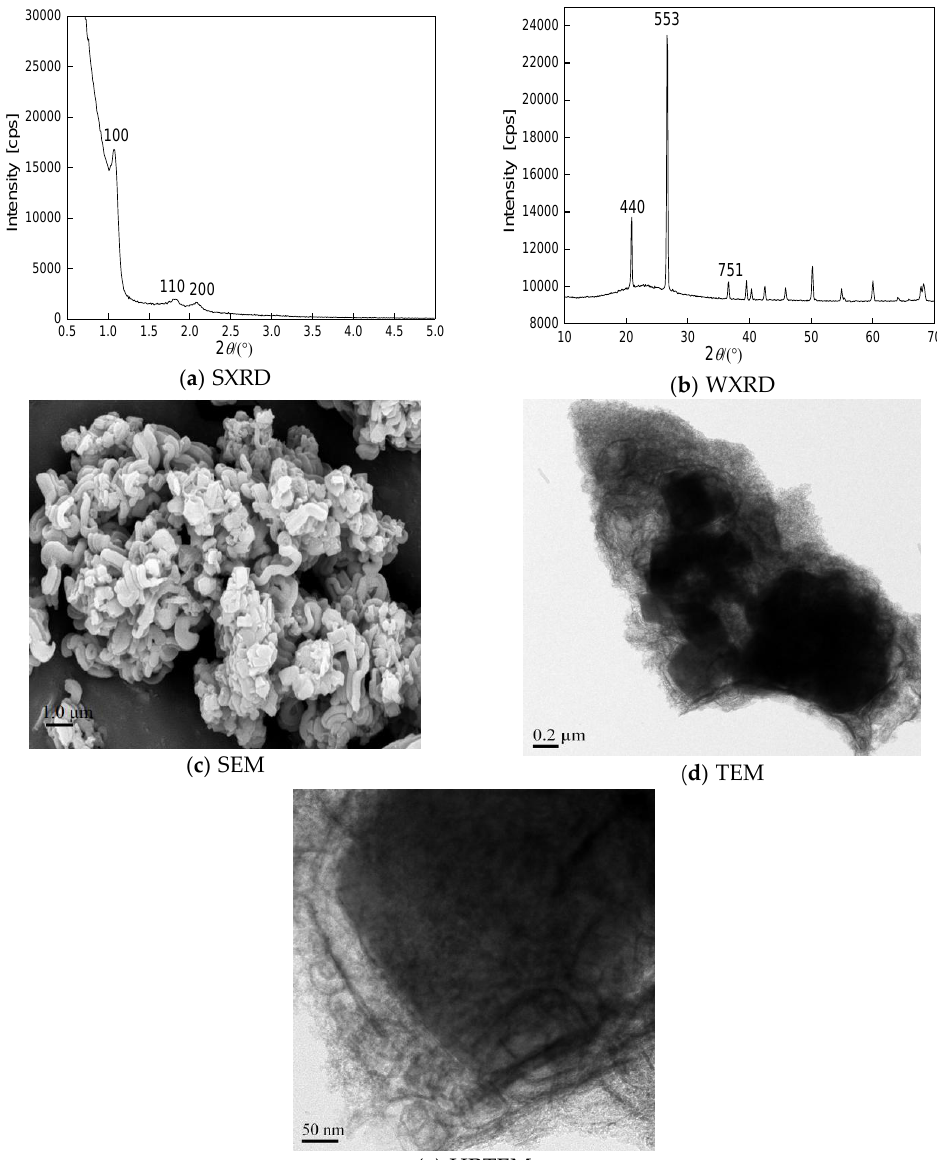
Figure 1. X-ray diffraction (XRD), scanning electron microscopy (SEM), transmission electron microscopy (TEM), and HRTEM (High power transmission electron microscopy photos) of YSV.